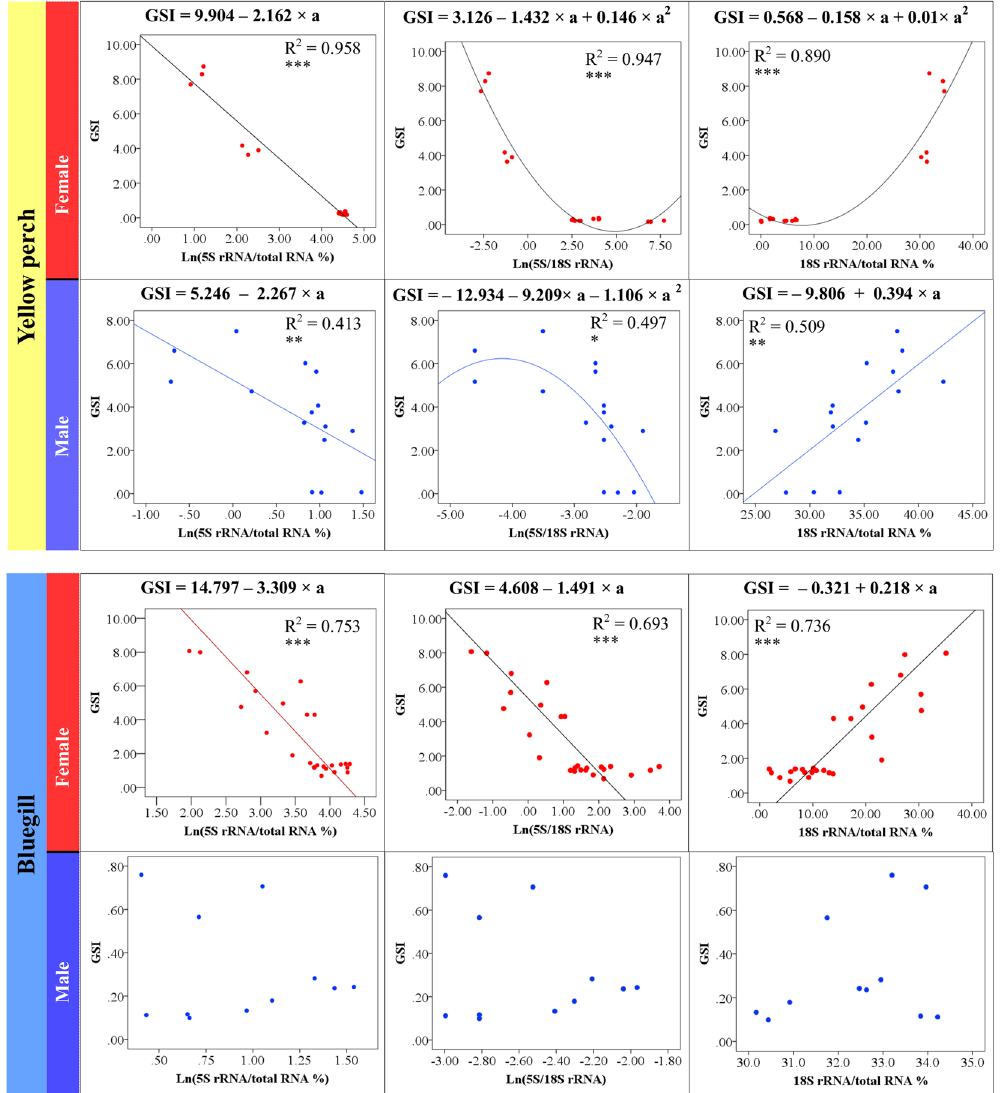
Figure 2. Regression of gonadosomatic index (GSI) and three ribosome RNA (rRNA) related indexes of females and males in fish species displaying synchronous (yellow perch) and asynchronous (bluegill) ovary development. Ln(5S rRNA/total RNA%), the natural logarithm of the percent of 5S rRNA relative to total RNA; Ln(5S/18S rRNA), the natural logarithm of the relative content of 5S rRNA to 18S rRNA; 18S rRNA/total RNA %, the percent of 18S rRNA relative to total RNA. The formula above each graph represents best curve fit generated by Curve Estimation in SPSS program (version 19). The Number of * under R square indicate the P value for formula estimation, with *** , ** , * represent P < 0.001, P < 0.01, and P < 0.05,